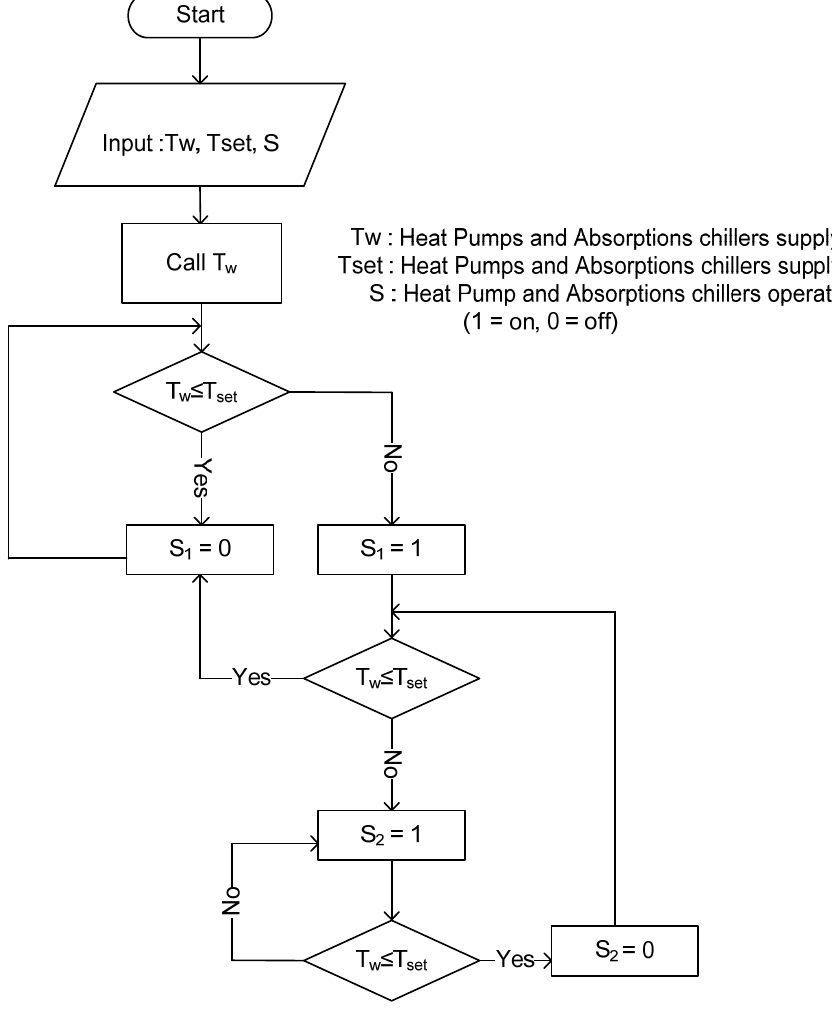
Figure 5. Control algorithms of the existing operating condition (Case